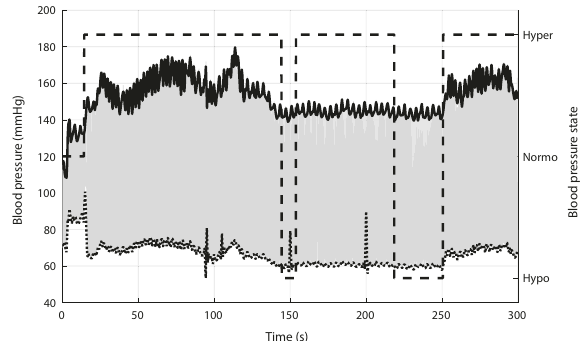
Fig. 5 Arterial blood pressure signal analysis. Example of the analysis of a 5-min arterial blood pressure (ABP, gray line) signal, with the trends for systolic (SBP, continuous line) and diastolic (DBP, dotted line) blood pressure, as well as the determination of blood pressure state (BP state, dashed line). Hypo hypotension, Normo normotension, Hyper